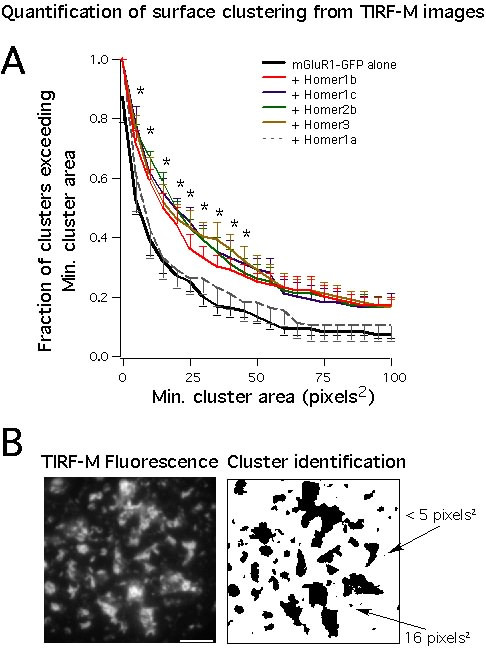
A, Cumulative histograms showing average (error bars indicate SEM) fraction of clusters in cells as a function of cluster size. The data analyzed were from the neurons described in Figure 1. [Asterisks indicate a statistically significant change from control for 1 or more long Homer protein groups.] B, An illustration of the particle analysis for a Homer 2b co-expressing cell. Left shows the image of the region of interest for this cell. Right shows the areas exceeding 1.5× the average fluorescence of the region of interest. 'Clusters' were defined as contiguous regions above this threshold. Two examples of clusters of various sizes are shown. Differences were seen in cluster size ranging from 10 to 50 pixels2. Asterisks indicate bins at which all long Homer groups differed from control and + Homer 1a cells. Scale bar is 5 μm.